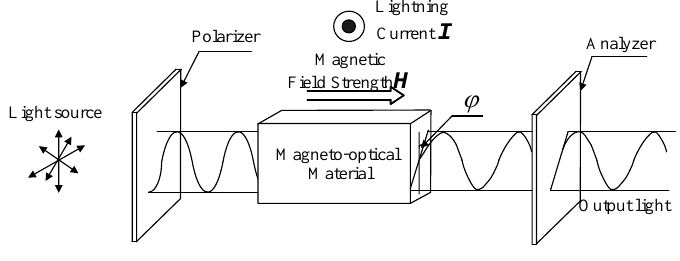
Figure 1. Faraday magneto - optical effect.